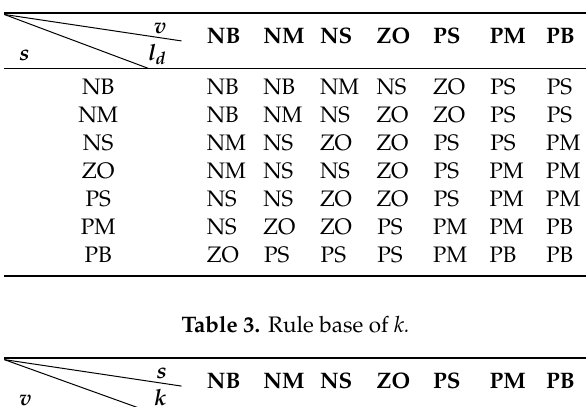
Table 2. Rule base of l’ d .